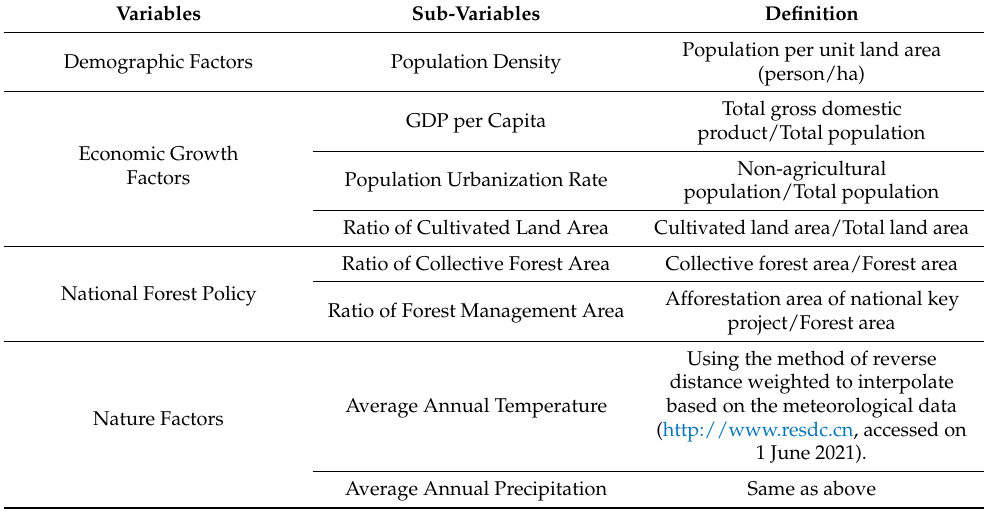
Table 1. Selection and interpretation of explanatory variables of forest